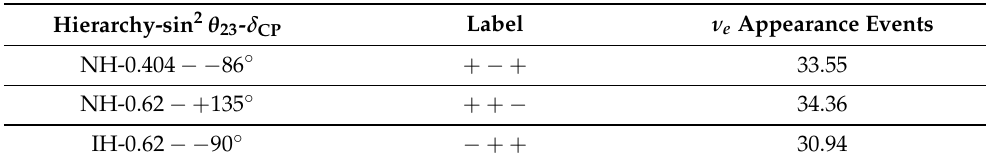
Table 5. Expected ν e appearance events of NO ν A for 6.05 × 10 20 POT, and for the three solutions in Ref. [60].